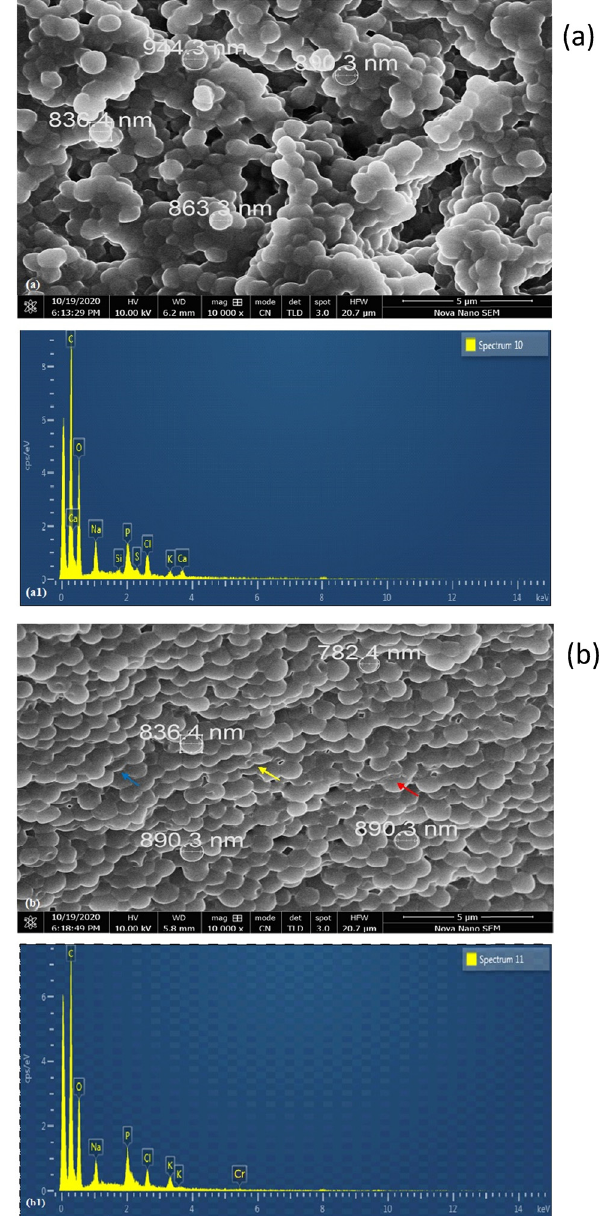
Figure 3: SEM micrographs of chromate - tolerant bacterium UT8 ( a ) no chromate treatment and ( b ) chromate treatment, red arrow indicates EPS, yellow arrow shows cell deformity, and blue arrow shows cell aggregation, ( a1 ) EDS analysis of strain UT8 with no chromate exposure and ( b1 ) EDS analysis of strain UT8 with chromate